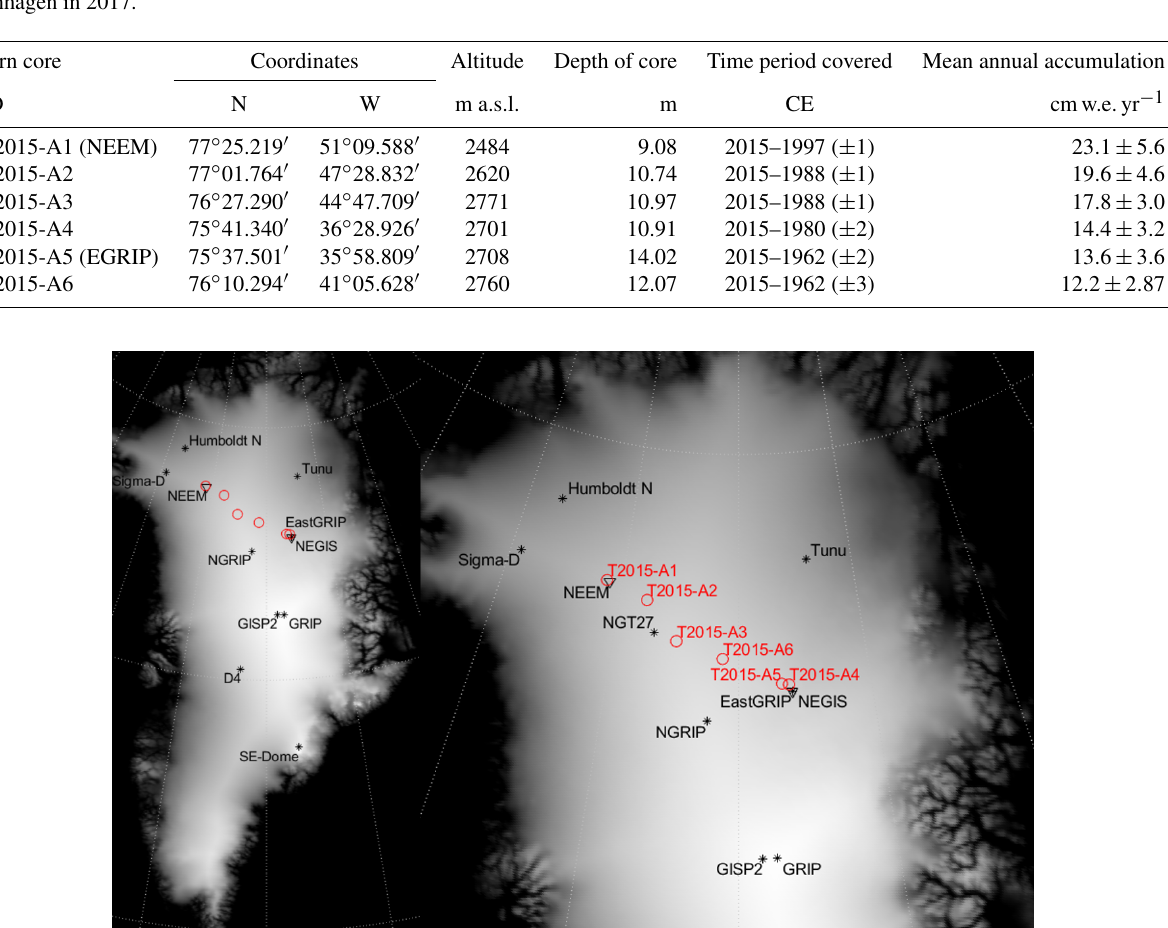
Figure 1. The six drill sites for the shallow firn cores investigated in this study (red circles) and the sites of other ice and firn cores mentioned in this study (black stars) on a background of Greenland surface elevation (SeaRISE dataset, Bamber, 2001).